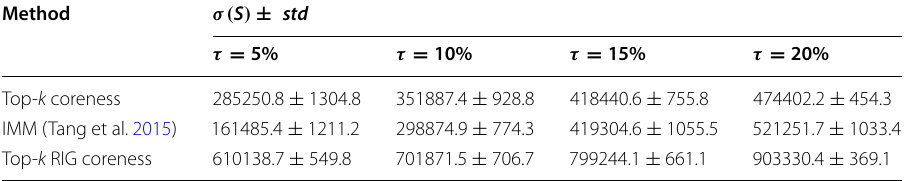
Table 8 Comparison with the IC model for several seed set sizes (50 simulations)